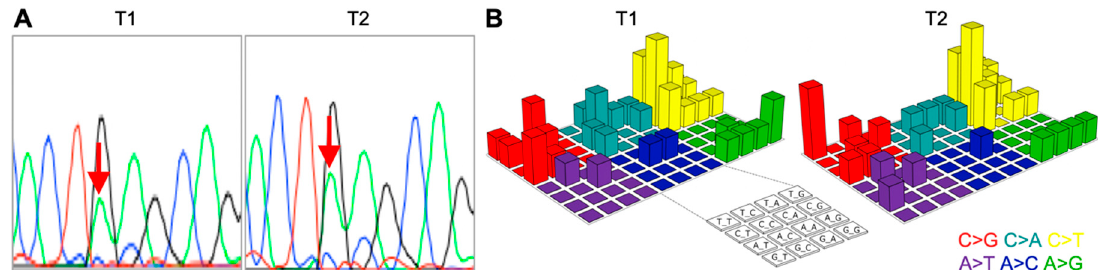
Figure 1. Quality assurance of next-generation sequencing data. A , Verification of mutations in PIK3CA (c.1633G>A) by Sanger sequencing. Red arrows show variant. B , Lego plots showing mutational patterns in a three-base context. The identified somatic single-nucleotide variants are grouped based on base substitution pattern and the neighboring bases.